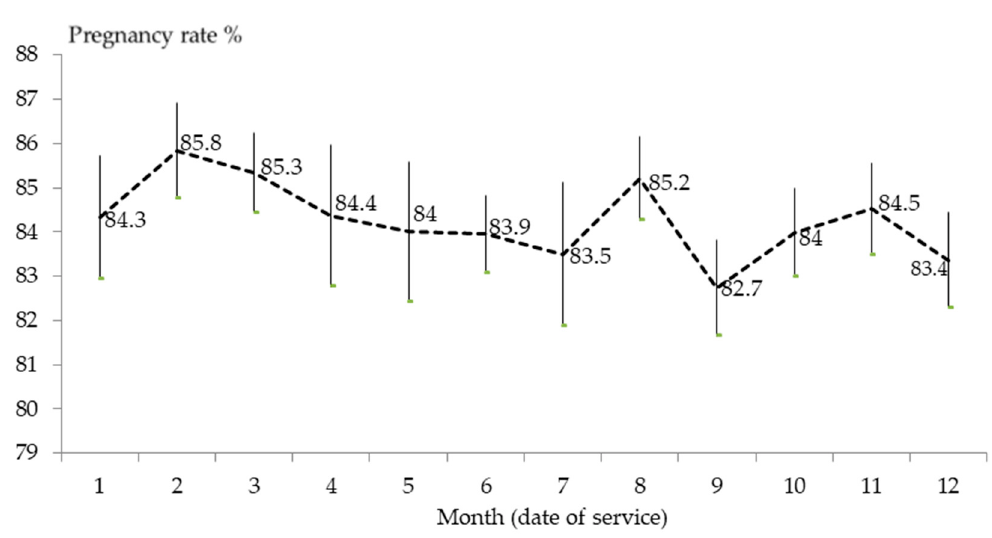
Figure 3. Monthly pregnancy rates and SEM, based on 427 cohorts with 190,508 does palpated by producers on 134 farms between 2014 and 2019.